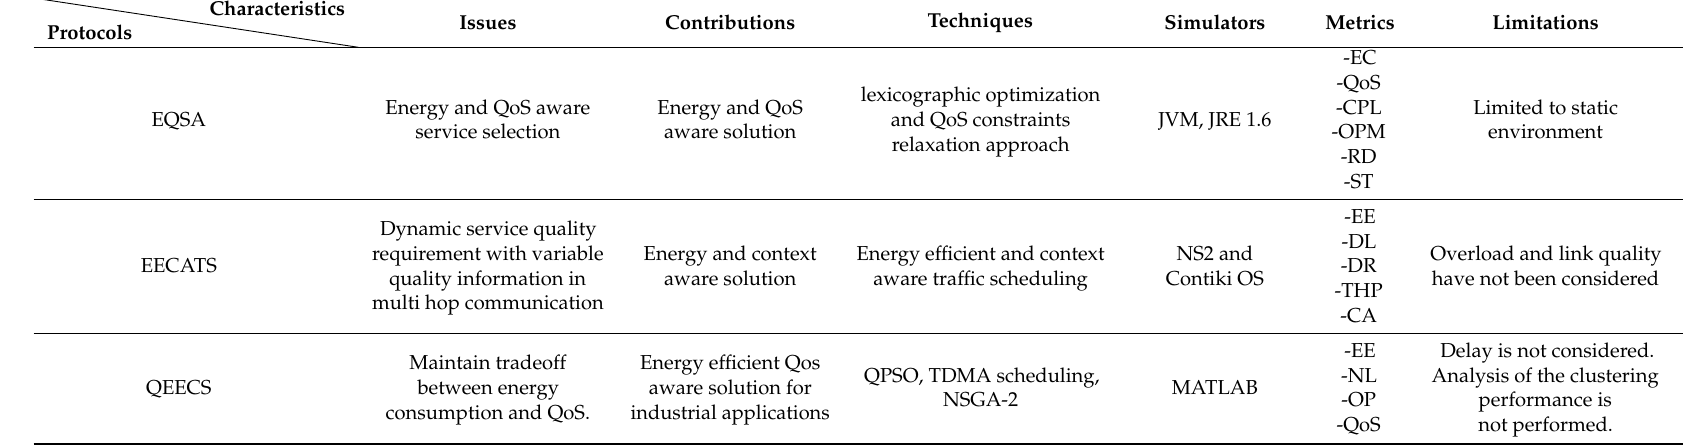
Table 8. Summary of energy efficient scheduling techniques.